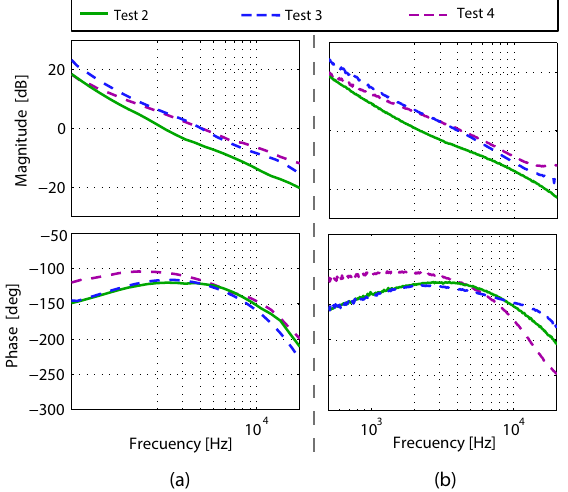
Figure 6. Voltage loop-gain Bode plots: ( a ) simulated, ( b )